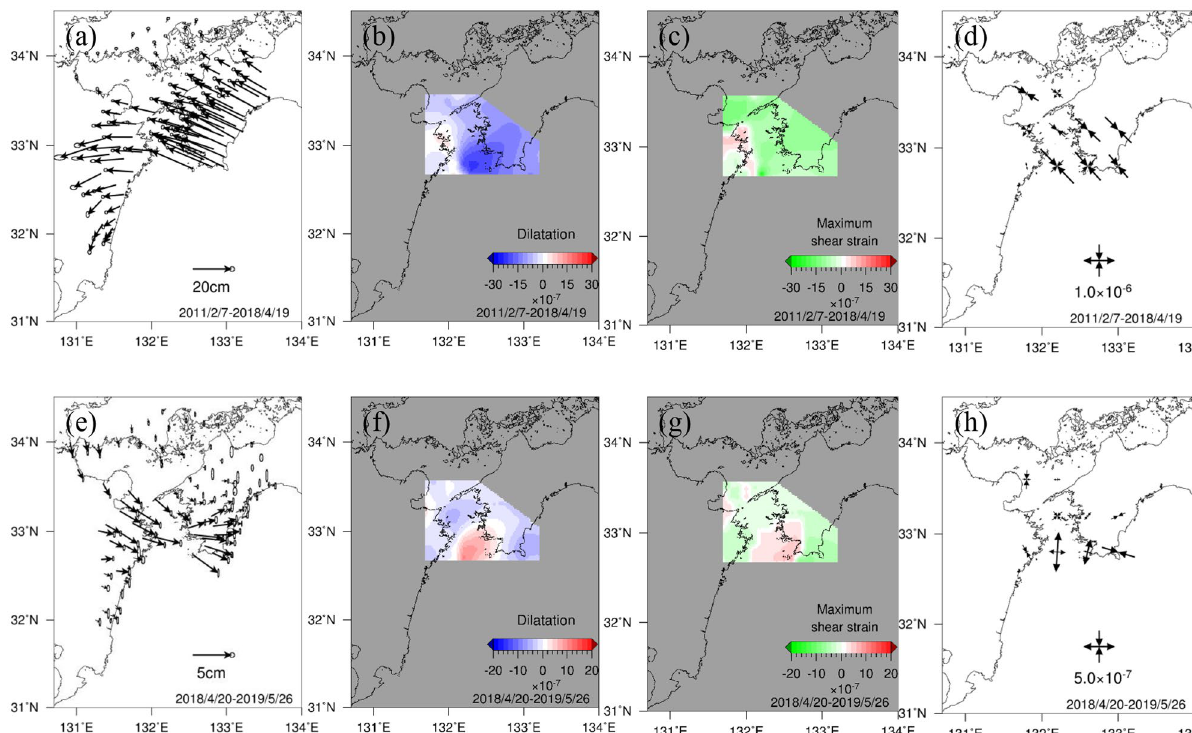
Figure 4. Spatial distributions of displacement, dilatation, maximum shear strain, and principal strain before (7 February 2011–19 April 2018) and during (20 April 2018–26 May 2019) the Bungo Channel L-SSE (2). The expressions of the figures are the same as those in Fig. 2a–h. The map was created by using the Generic Mapping Tools (GMT) 27 (version: GMT3.4.6, URL link: https:// www. gener ic- mappi ng- tools. org/ downl